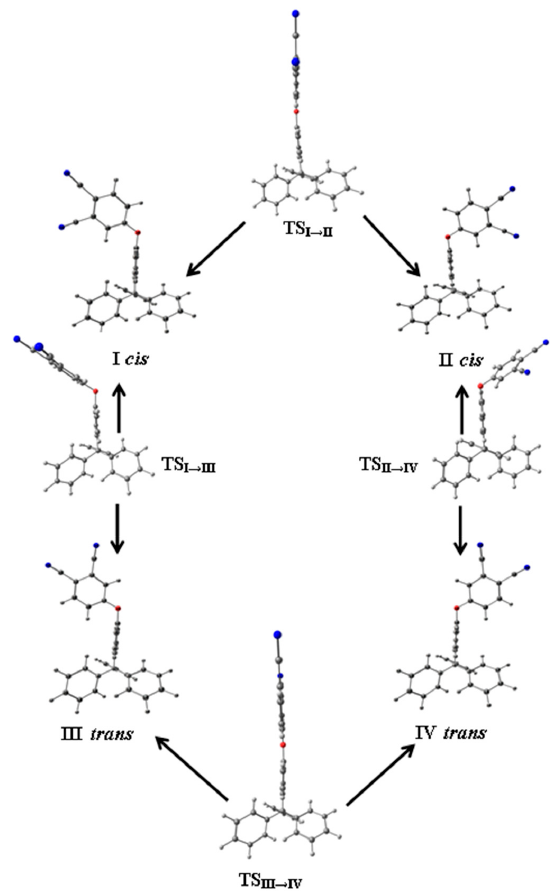
bond in the trityl group. The ϕ [C O2 C O1 OC N1 ], ϕ [C O3 C O4 C t C t1 ], and ϕ [C O1 OC N1 C N2 ] dihedral angles were scanned with a step of 2° or 10°.